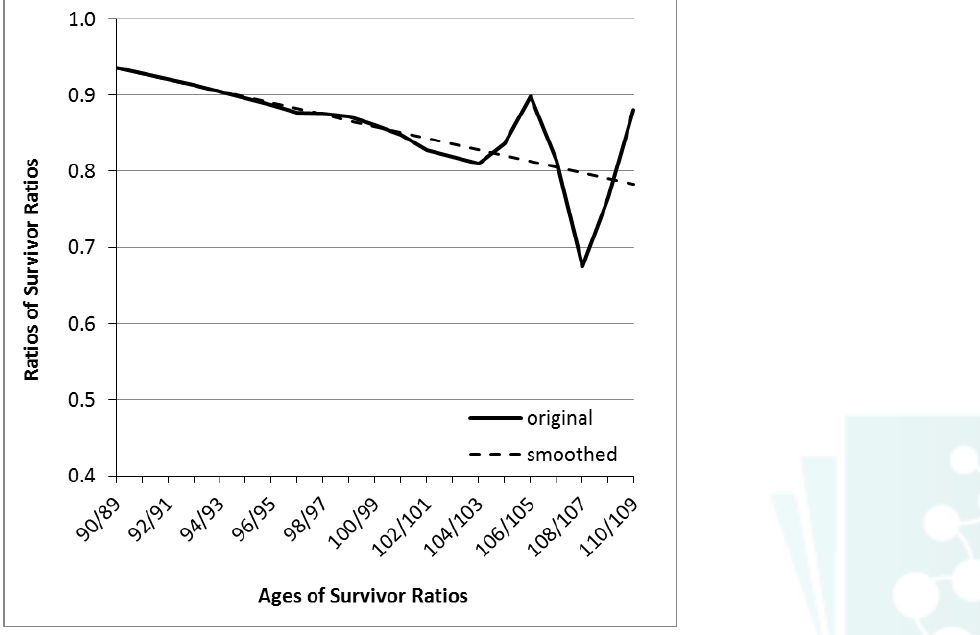
Figure 3: Ratios of female Survivor Ratios,